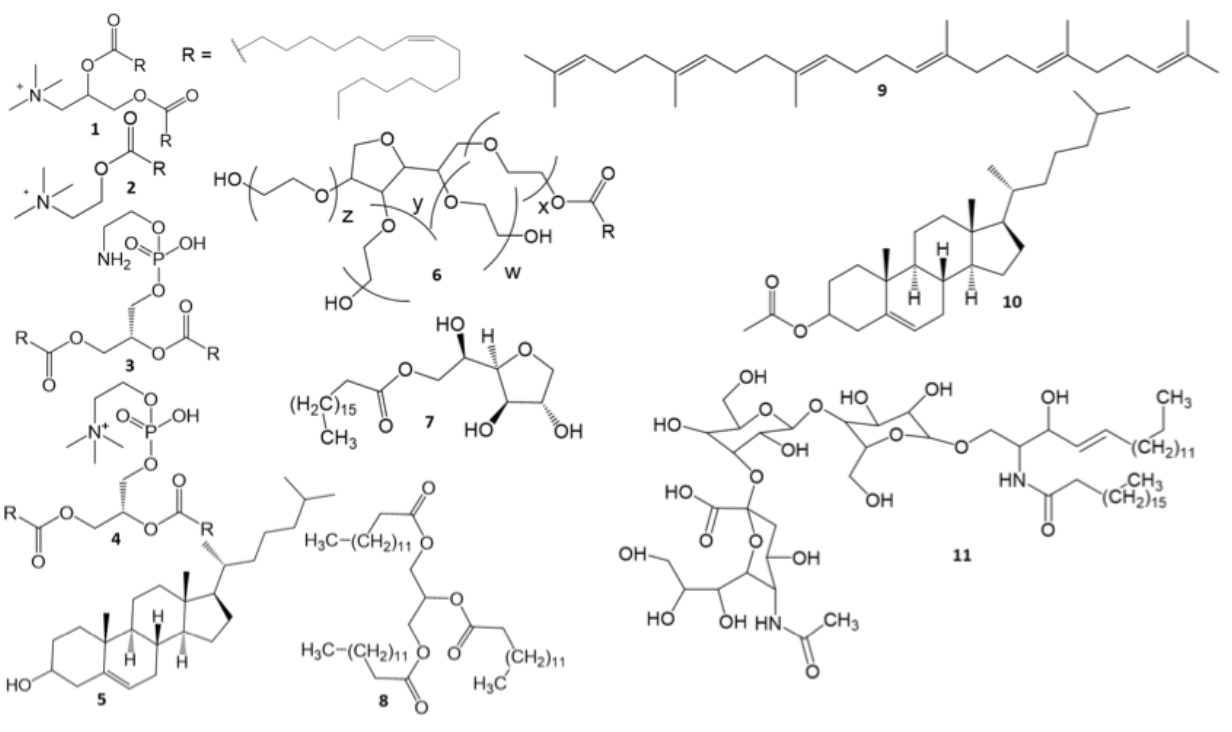
Figure 1. Structural formulas of the LNP and cLNP components. Cationic lipids: 1 , dioleoyltrime- thylaminopropane (DOTAP); 2 , oleoylcholine (Ol-Ch). Structural lipids: 3 , dioleoylphosphatidyleth- anolamine (DOPE); 4 , dioleoylphosphatidylcholine (DOPC); 5 , cholesterol (Ch). Additional compo- nents: 6 , stearoylmonosorbitan (SPAN60); 7 , polyethylene glycol sorbitan monooleate (polysorbate 80 (PS80)), w + x + y = 20. Core lipids: 8 , coconut oil triglycerides (COTs); 9 , squalene (Sq); 10 , cho- lesterol acetate (ChA). Functional lipids: 11 , GM3 ganglioside (GM3).